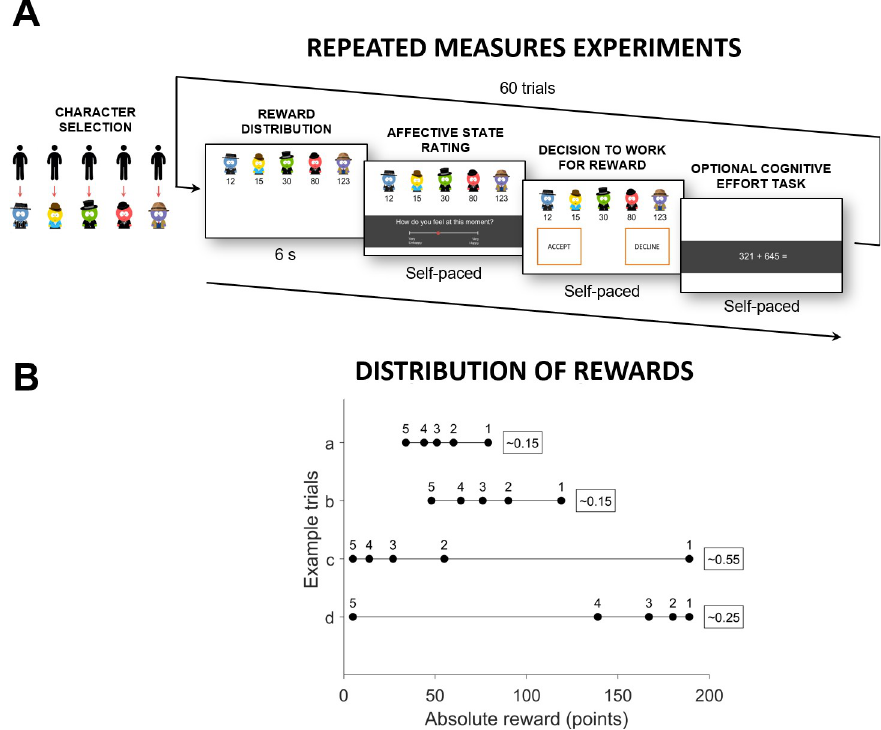
Fig 3. Behavioural task in Experiment 2 and 3. (A) Both Experiment 2 and 3 used a repeated measures design. Participants were invited to the lab in groups of five. To easily identify themselves during the experiment, each participant selected a cartoon avatar that would represent them throughout the task. They then retired to individual cubicles to complete the study. There were 60 trials in total. Each trial started with a display of all participants’ reward offers, that differed in rank, absolute reward, and level of unfairness between participants. After seeing the distribution of rewards, participants rated their current feelings and indicated whether they were willing to exert cognitive effort for their offered reward on that specific trial. If they decided to do so, they would complete three mathematical problems. If not, they would move on to the next trial. If a participant gave an incorrect answer to the mathematical problem, they would have to solve an additional one, until they completed three problems correctly. (B) For the repeated measure experiments, we created 30 income distributions based on a log-normal probability density function (corresponding to 10 levels of Gini index uniformly distributed between 15 and 55, with 3 different median values) Log-normal distribution approximates reward distributions encountered in real-world, such as income distributions within countries [25] and companies [26]. Because these distributions are always positively skewed, we also created 30 distributions that were negatively skewed and a mirror image of the positively skewed distributions. For illustration purposes, we plot four of these distributions. Each dot on the line represents one of five reward offers presented to participants. Numbers above the dots refer to the reward’s rank. Numbers in the rectangles refer to unfairness level, expressed in the Gini coefficient. Distribution a) is an example of a fair positively skewed distribution with a low median reward; distribution b) is an example of similarly fair distribution, but with a higher median value; Distribution c) is an example of an unfair positively skewed distribution, and distribution d) is an example of a negatively skewed distribution that is a mirror image of